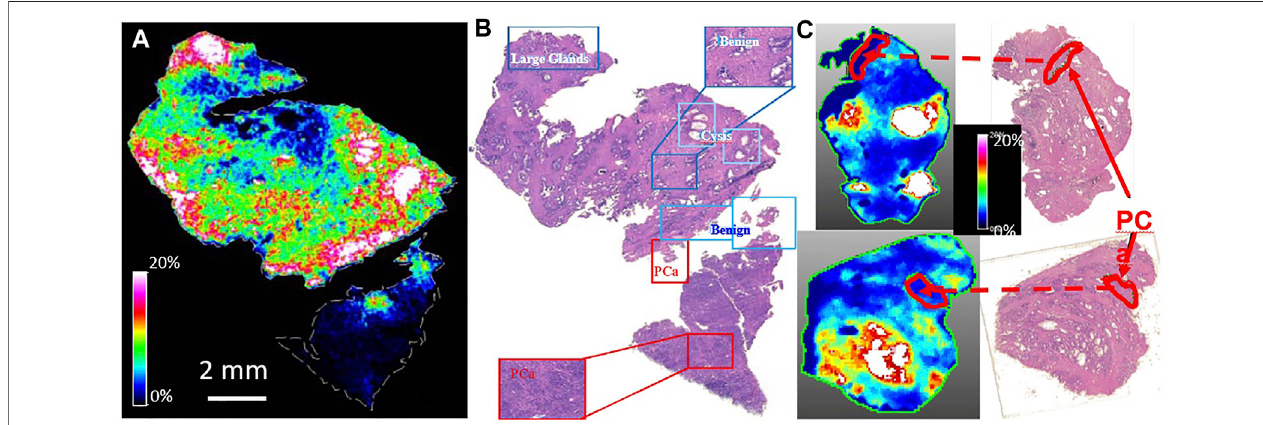
FIGURE 1 | MALDI MSI Con fi rmed HRMAS 1H NMR prediction of associations of spermine with histologically benign epithelia. De-identi fi ed human prostate tissuesfrom PCa patients wereevaluate byhistology and measured withMALDI MSI. (A) .Map of12C-Spermine (m/z: 203.223± 0.001Da) (B) . Histology identi fi cations of prostate tissue pathologies including, benign glands, cysts, and PCa lesions that located spermine onto the benign epithelial glands. (C) . Veri fi cations of spermine locations with other